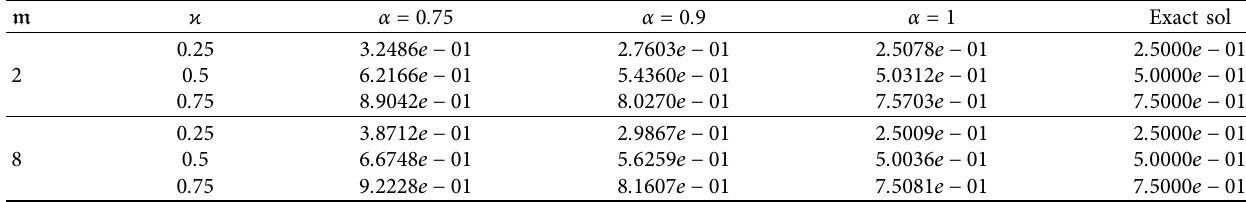
Table 6: Approximate solution values on diferent ϰ for diferent α comparing to the exact solution when α � 1 for m � 2 , 8 for Example 5.